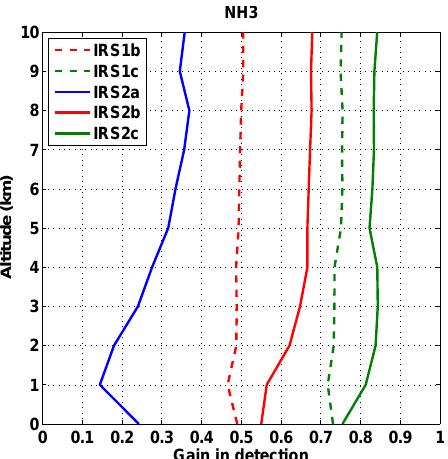
Figure 16. Impact study on the detection limit for NH 3 . The plot represents the relative difference ratio between the detection limit of each scenario and the IRS1a-IASI scenario, as a function of altitude, for a case representative of a tropical atmospheric